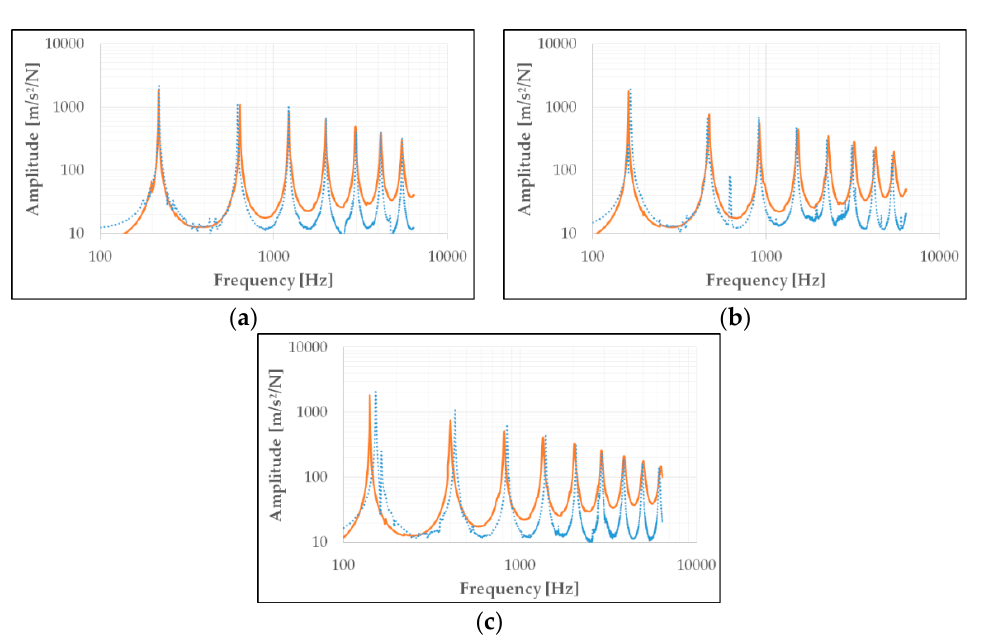
Figure 17. FRF of the simulation and the experiments of PA66-GF30 of the IF ( a ), MF ( b ) and CF ( c ) orientation at 23 °C and 0% rh.